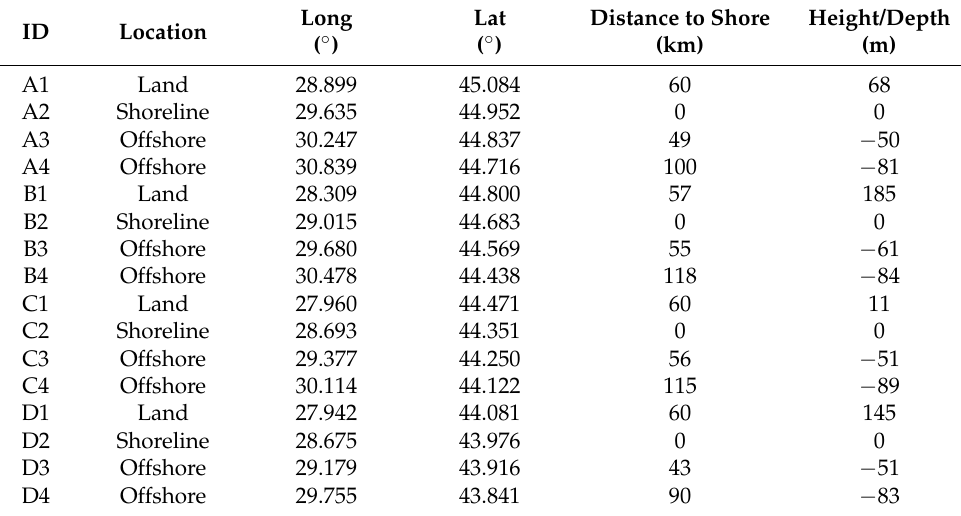
Figure 1. The Romanian coastal area, including the Exclusive Economic Zone (EEZ) boundaries and the reference sites considered. Map processed from Google Earth, 2021. Table 1. The main characteristics of the sites considered onshore and offshore of the Romanian coastal environment. Data obtained from Google Earth